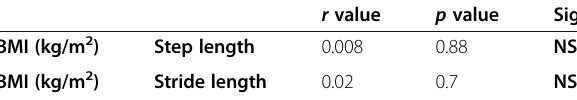
Table 3 Correlation between BMI and step length of the children